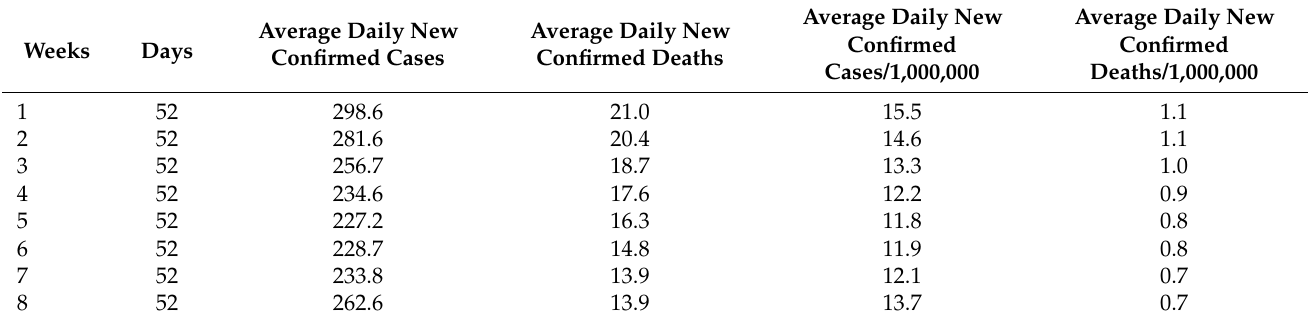
Table 1. Average number of cases during the lockdown in Romania.